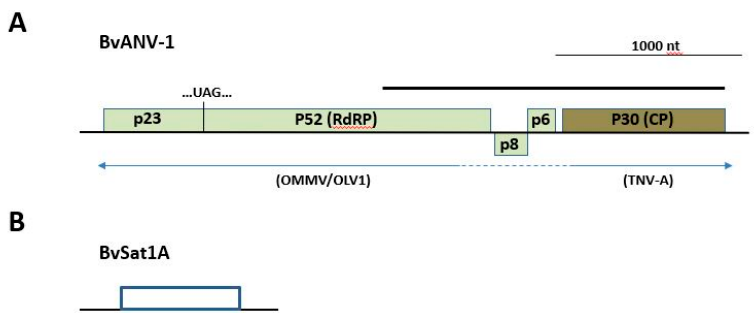
Figure 4. Genome map approximating the organization and size of putative novel viruses associated with sugar beet. ( A ) In the novel Alphanecrovirus (BvANV-1), the 5 (cid:48) -proximal ORF is interrupted by an amber stop codon (UAG), as is characteristic for several members of the Tombusviridae, and its predicted protein product possesses, along with the predicted movement proteins p8 and p6, greatest similarity to those of the closely related viruses OLV-1 and OMMV. The predicted coat protein (P30-CP) is more closely related to that of TNV-A. Both the 5 (cid:48) - and 3 (cid:48) -UTRs possess the greatest similarity to those from TNV-A. The solid bar above the map represents the single amplicon produced within the study, validating the integrity of the discovered viral genome. ( B ) Approximate genome size and predicted coding information for satellite virus BvSat1A. A single ORF encodes a putative protein with similarity to satellite maize white line mosaic virus. Table 3. Percent identity between the putative novel Necrovirus genome discovered in sugar beet and domains encoded within the genomes of established Alphanecroviruses.